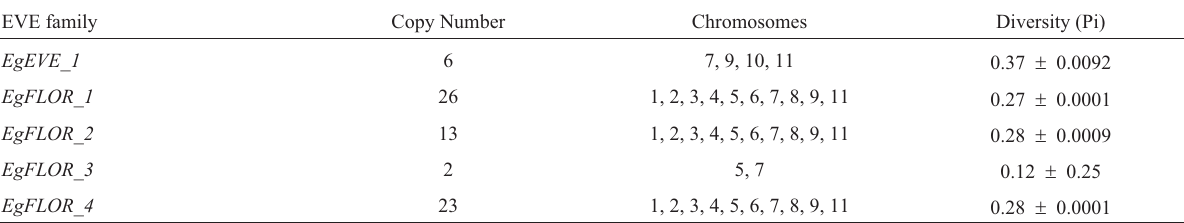
Table 2 - Genomic distribution and diversity of EVE families.